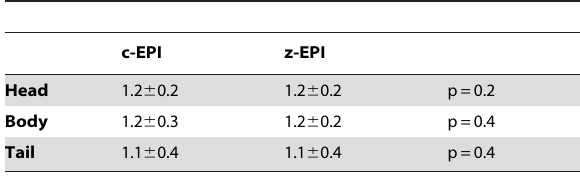
Table 3. Mean ADC values ( 6 10 2 3 s/mm 2 ) and standard deviations in the pancreas for both